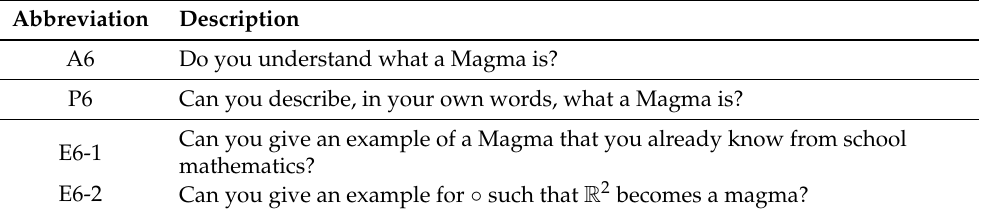
Table A6. Overview and descriptions for all units in the interview regarding key idea 6 ( Magmas , cf. Table 1). A stands for acceptance, P for paraphrasing, and E for exercise.